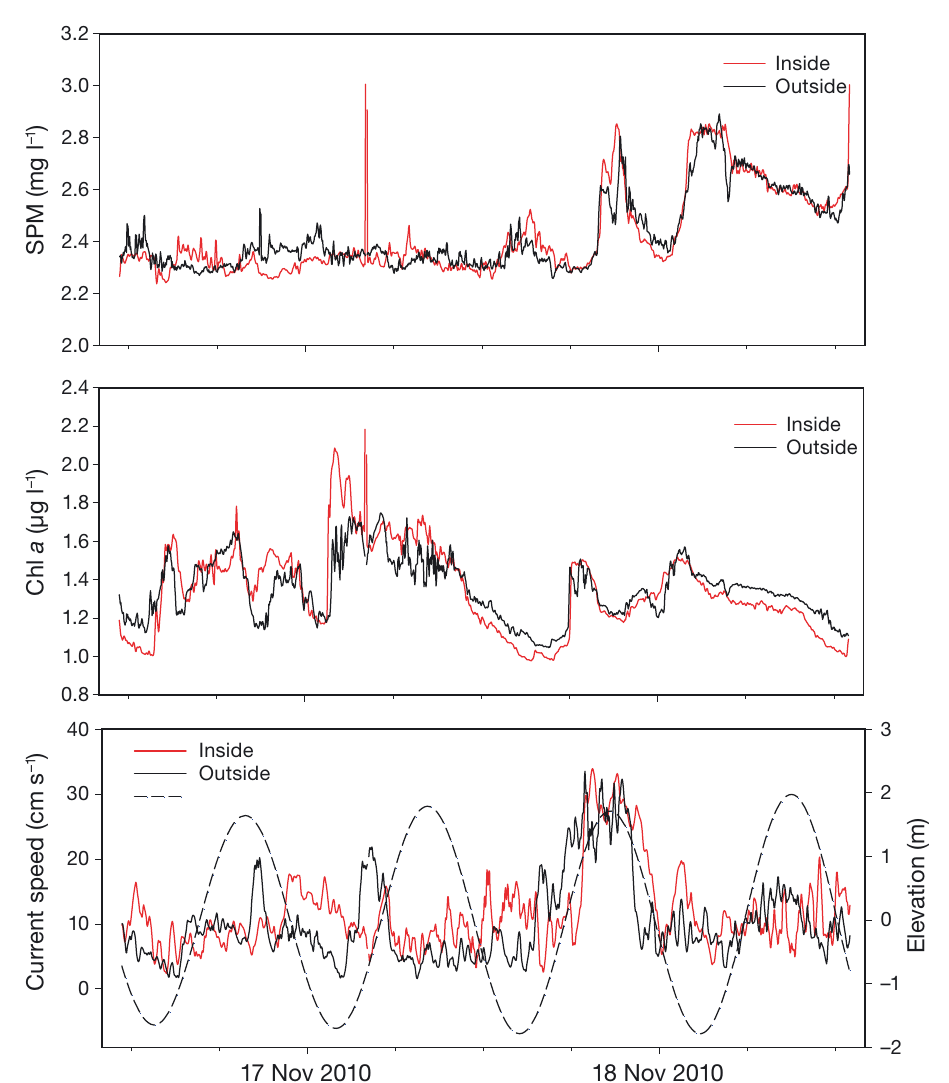
Fig. 2. Suspended particulate matter (SPM) and chlorophyll a (chl a ) concentrations and current speeds, collected at 2 min in- tervals at 5 m depth, at the Navy Islands salmon farm. Data are from the ‘inside’ and ‘outside’ stations shown in Fig. 1. All instruments were located within 3 m of a net-pen. The dashed line is the predicted tidal